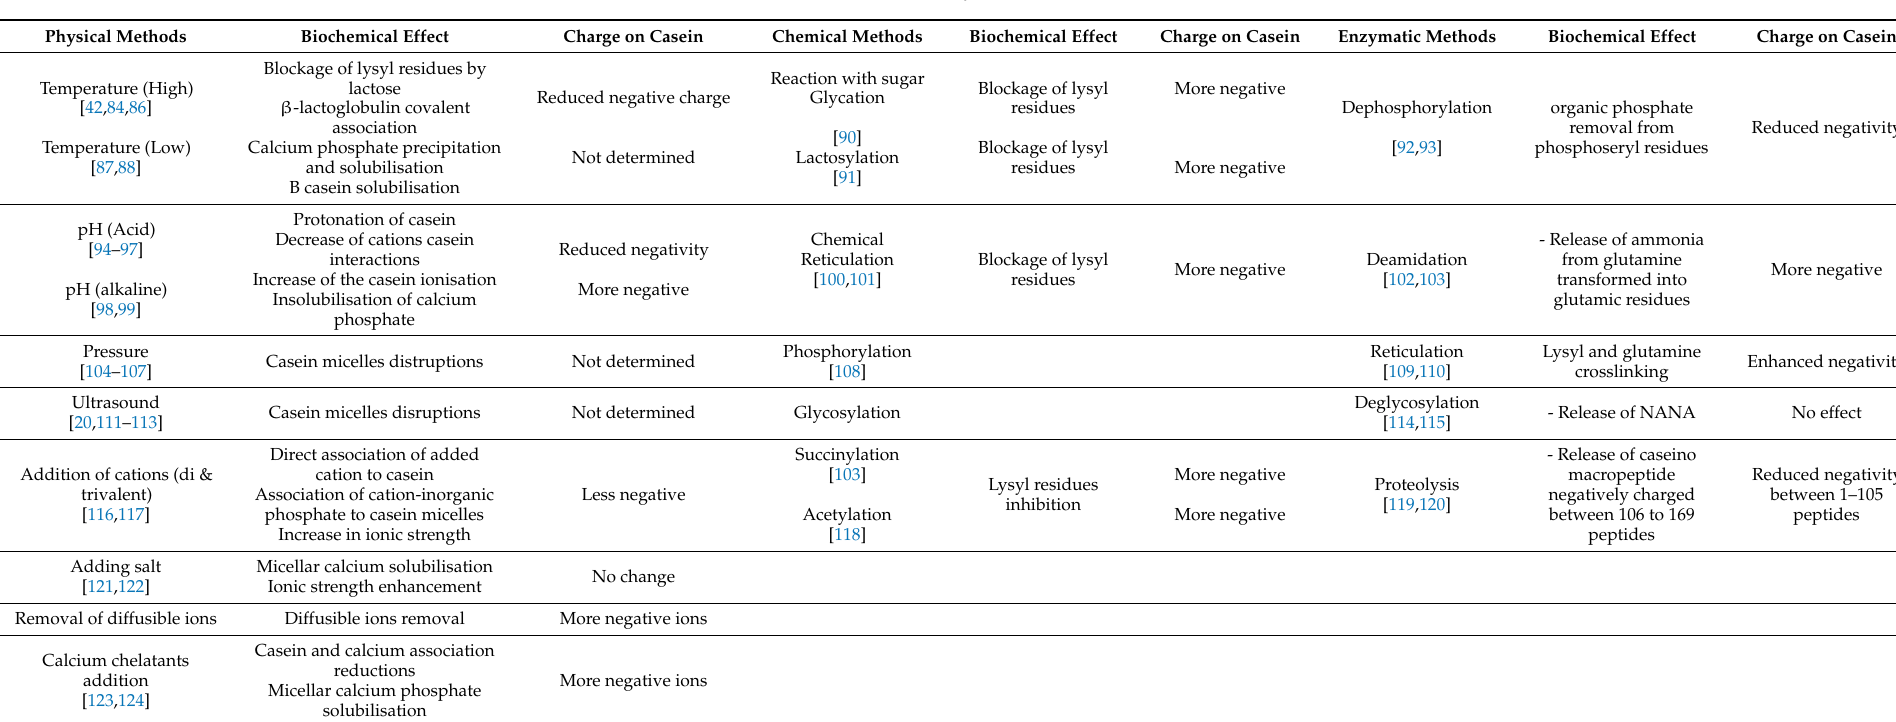
Table 2. Intrinsic and Extrinsic Factors to Modify Casein Micelles Structure and